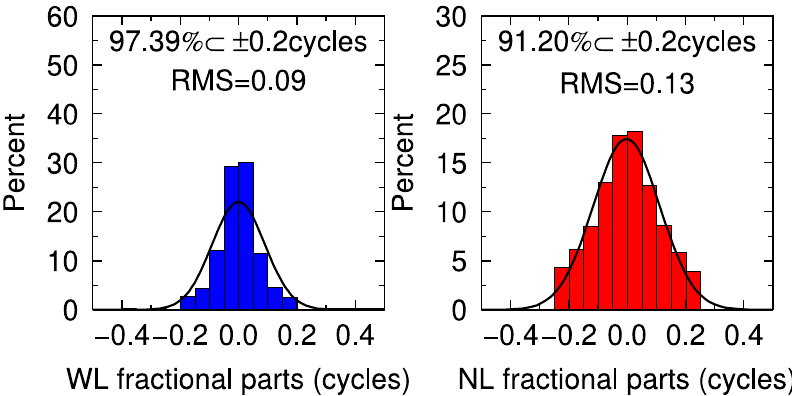
Figure 5. Distribution of the fractional parts of all the WL and NL ambiguities for network resolution on DOY 002.